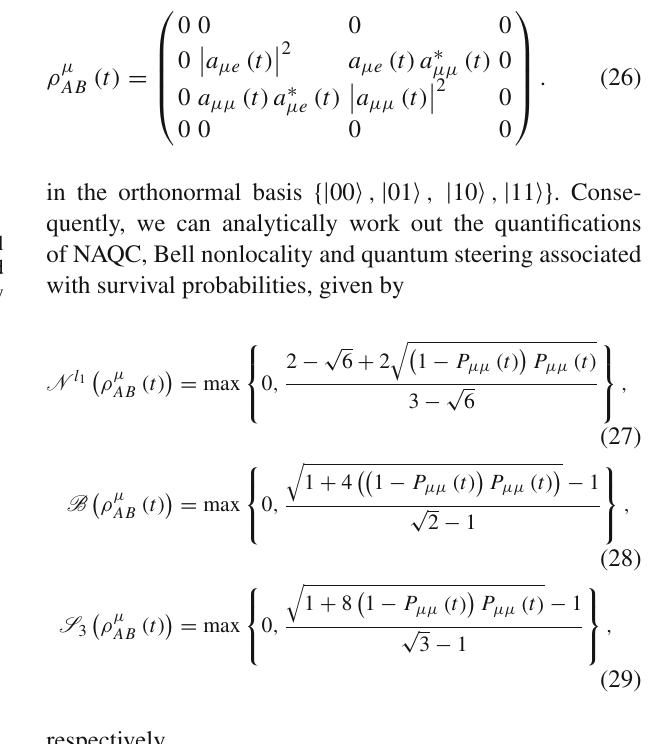
The survival probability for the muon flavor state ν μ is quan- tified by P μμ ( t ) = for the electron flavor state ν e is P μ e ( t ) = tively. The effective atmospheric neutrino Δ m 2 μμ measured in ν μ disappearance experiments is